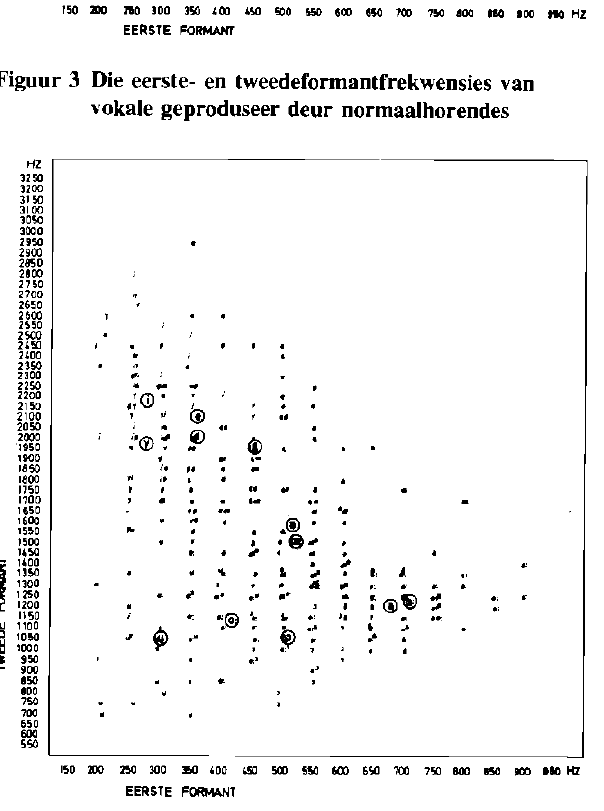
Figuur 4 Die eerste- en tweedeformantfrekwensies van vokale geproduseer deur hardhorendes Derdens, wanneer die resultate van die dowe groep bestudeer word (Figuur 5) is die bogenoemde verskynsel nog meer opvallend. Die gemiddelde eerste- en tweedeformantwaardes is in" 'n klein frek- tweedeformantfrekwensies van die vokale van die drie groepe sprek- ers verskyn in die Bylaag).